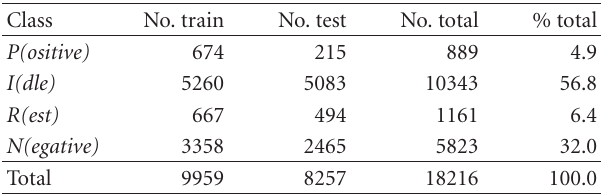
Table 4: Emotion classes and their SC-based frequencies.